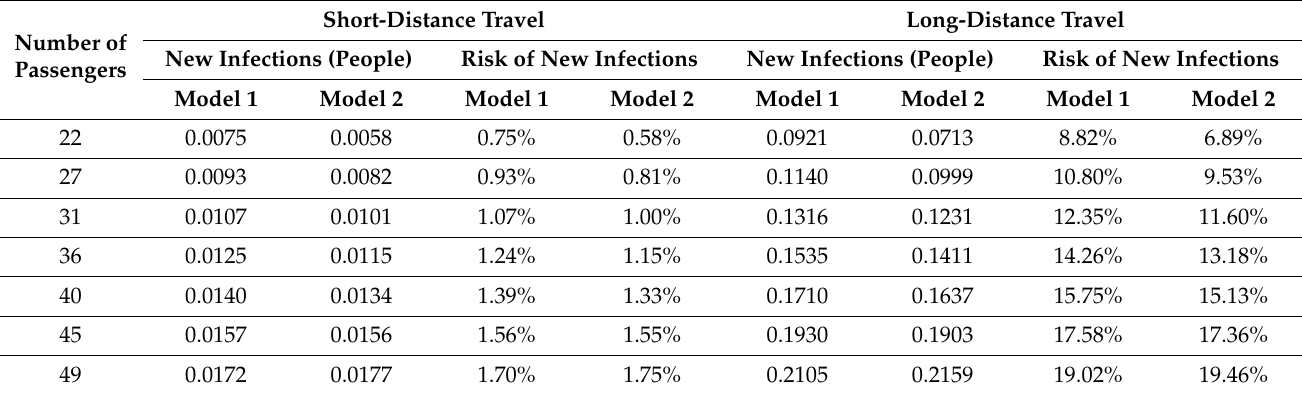
Table 2. Analysis of the risk of infection with passenger number reduction under short- and long-distance travel conditions. Number